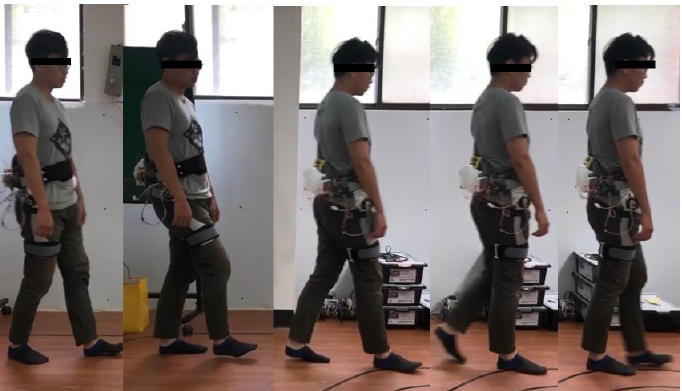
Figure 8. Walking experiments for gait rehabilitation with robotic hip exoskeleton.